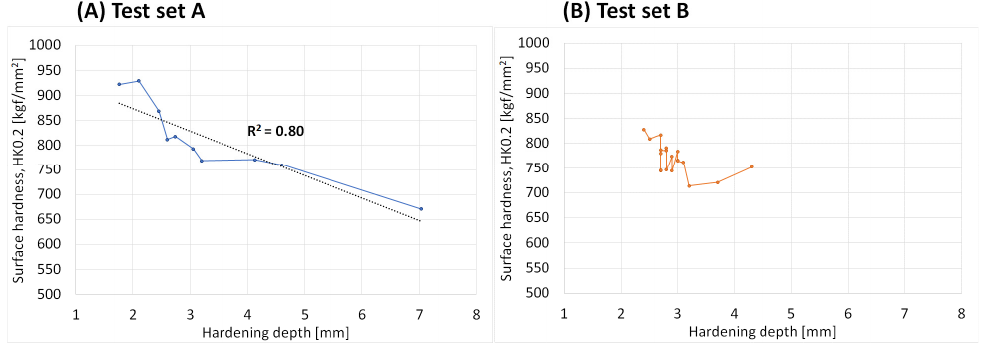
Figure 7. Surface hardness, Knoop (HK0.2), versus the hardness depth of the induction hardened samples from ( A ) test set A and ( B ) test set B.